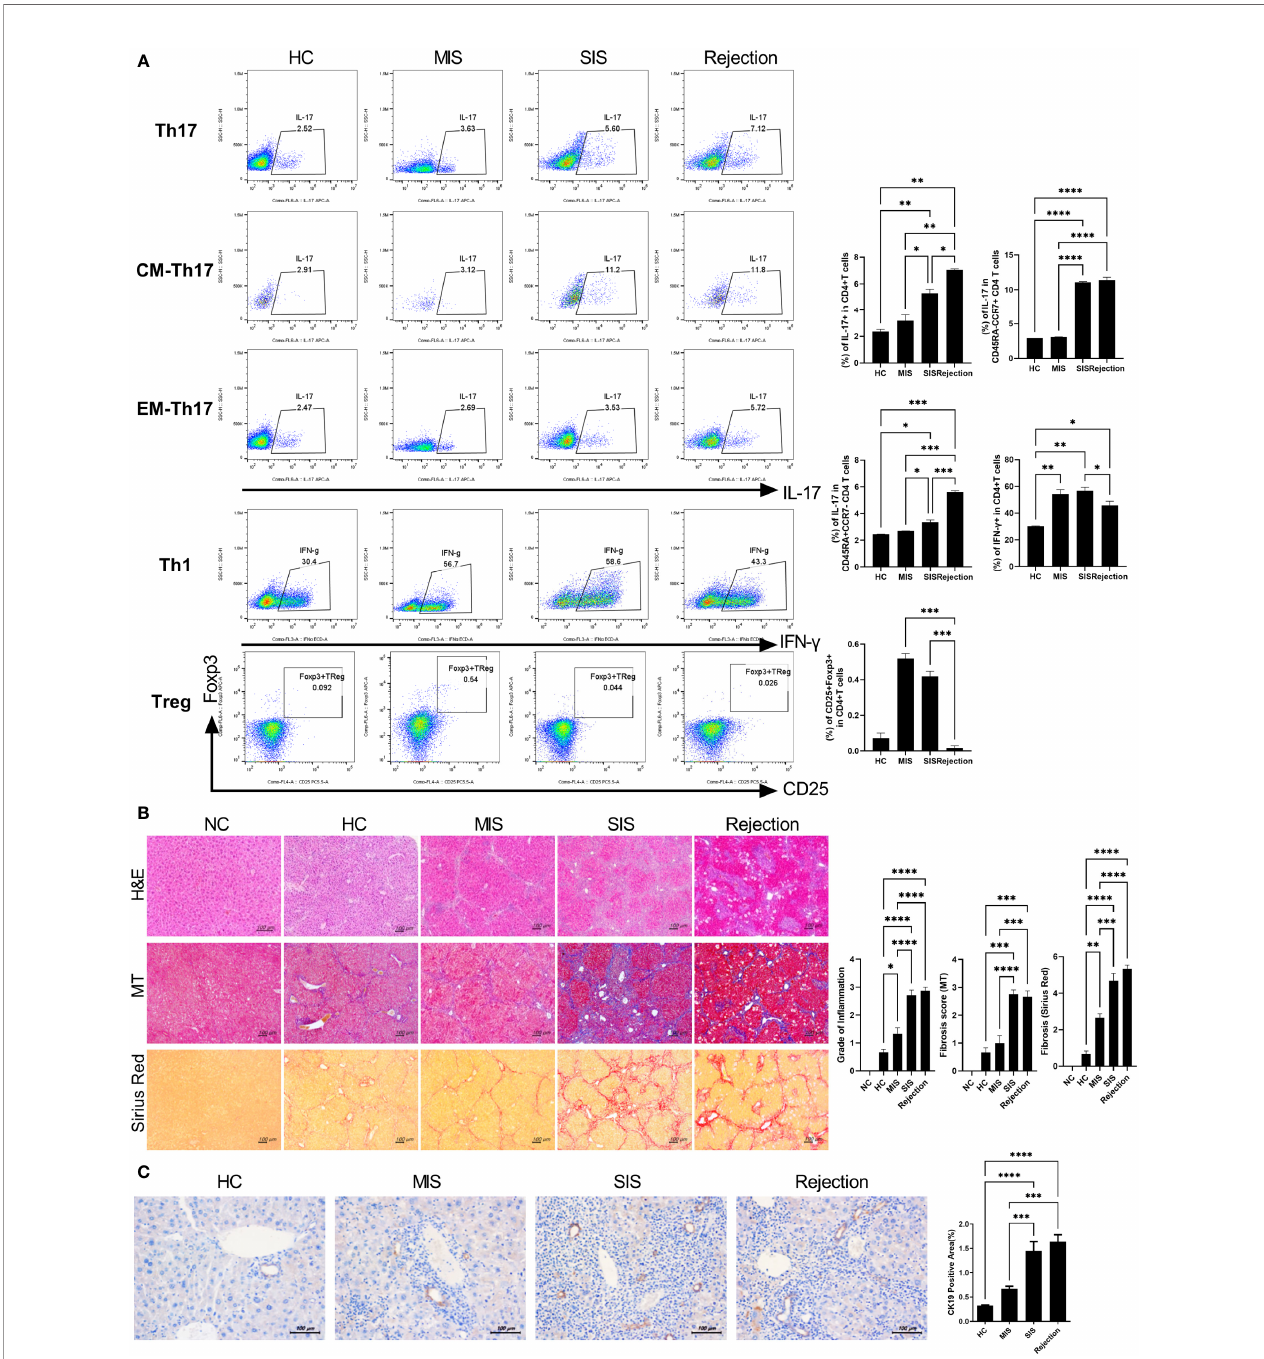
FIGURE 3 | Characterization of patient-derived avatar models by immune pro fi ling of human lymphocytes and analysis of liver histology in the model. (A) Representative fl ow cytometric plot expressing the proportion of CD4 + T-cell subtypes in the spleen of each humanized mouse group. At 7 weeks after induction of humanized mice, the engraftment levels of human T-cell subset in the spleen of each patient-derived avatar group were analyzed using fl ow cytometry. The percentage of each cell population among CD4 + T cells is shown in the right upper panel. (B) Representative liver histology stained with H&E, MT, and Sirius red in paraf fi n-embedded avatar models. Liver tissue sections were harvested from humanized mice at 7 weeks after adoptive transfer with PBMC preparations from HC or LT patients. In fl ammation and fi brosis scores are shown in the right panel. (C) Representative images of IHC with CK19 antibodies. Bars indicate the percentages of positive areas per fi eld. Data are the means±SEM of two replicates. * P < 0.05, ** P < 0.01, *** P < 0.001, **** P < 0.0001. H&E, hematoxylin and eosin; MT, Masson ’ s trichrome; NC, negative control; HC, healthy control; LT, liver transplantation; IHC, immunohistochemistry; MIS, mild in fl ammation in stable; SIS, severe in fl ammation in stable; CM, central memory; EM, effector